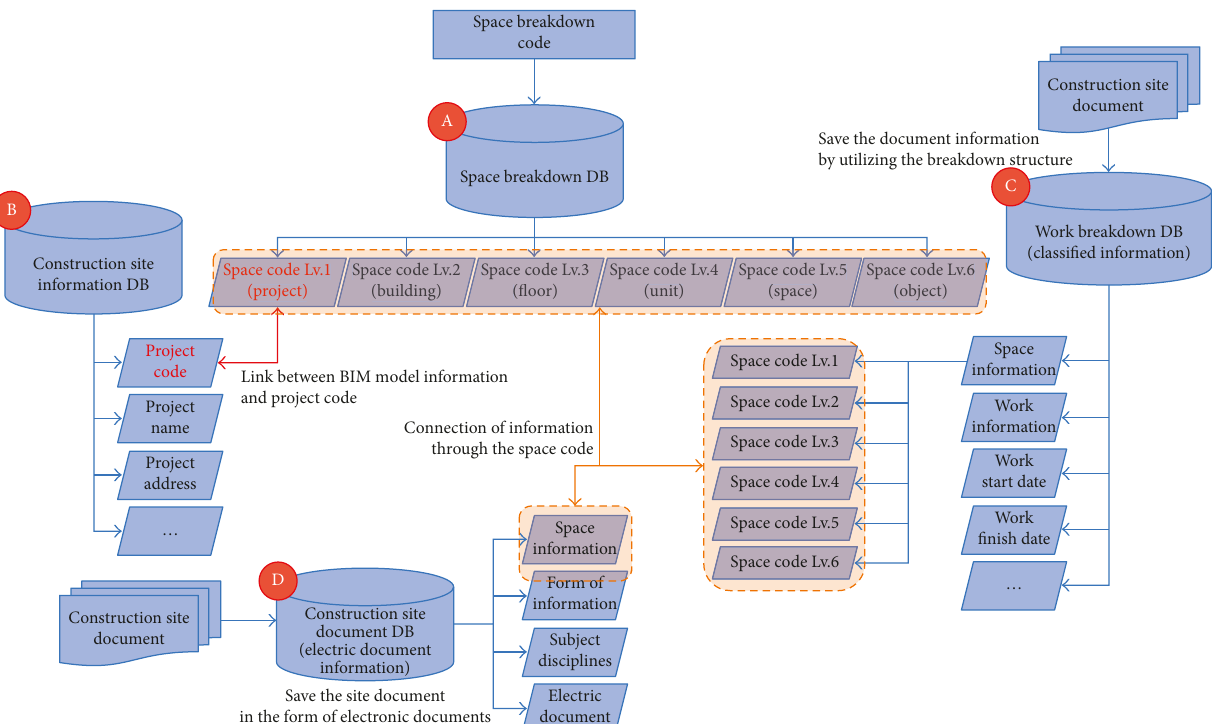
Figure 7: BIM-based database system for construction information.